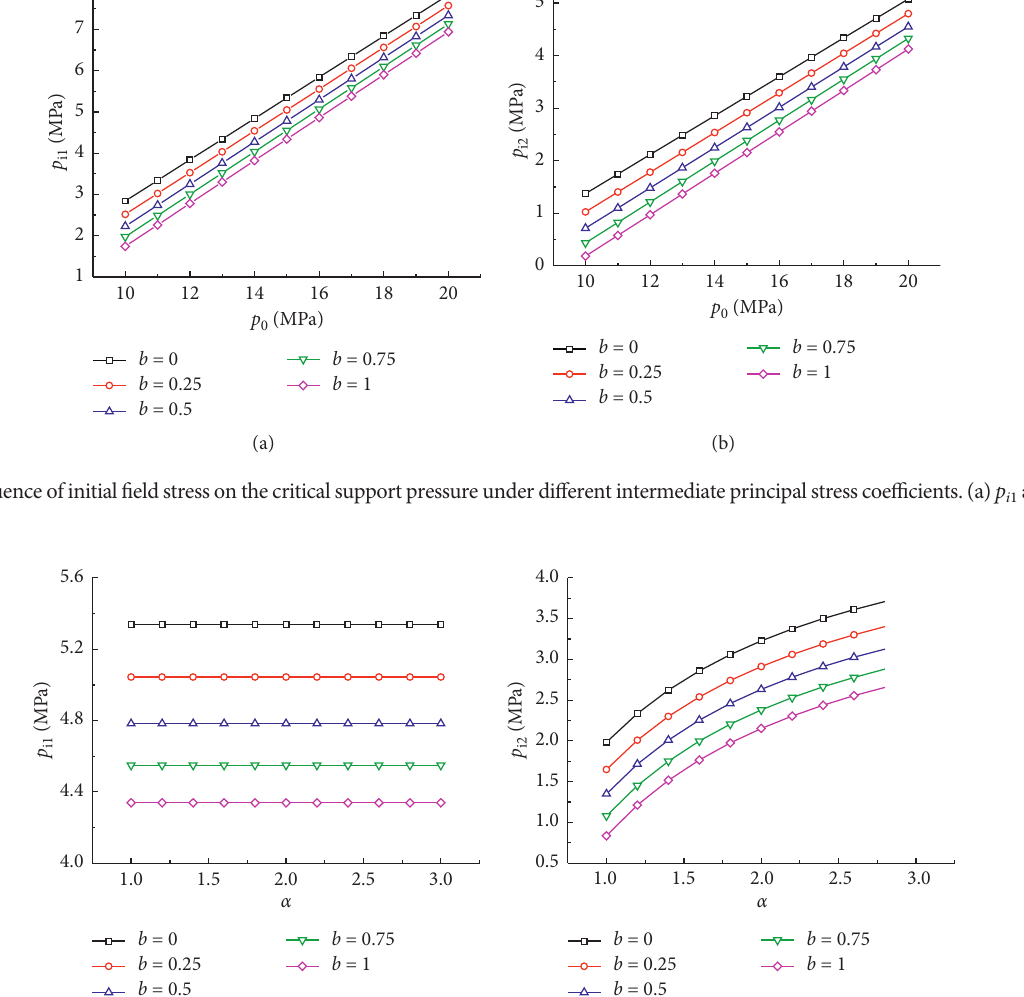
Figure 6: Influence of the softening coefficient on the critical support pressure under different intermediate principal stress co- efficients. (a) p i 1 and (b) p i 2 .